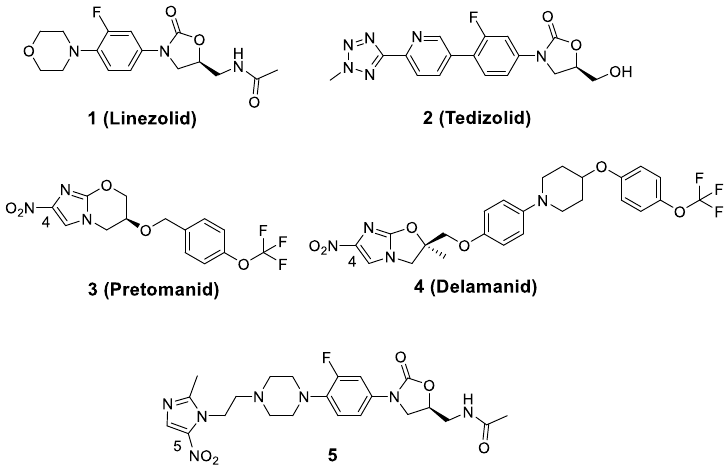
Figure 1. Structures of Linezolid, Tedizolid, Pretomanid, Delamanid and Conjugate Molecule 5.